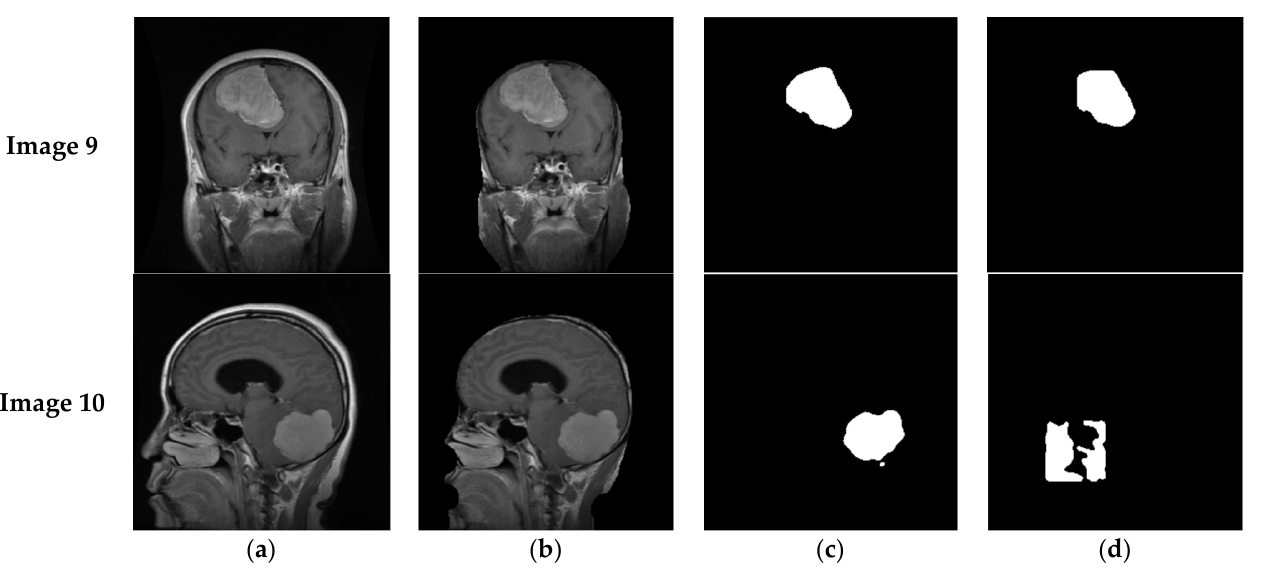
Figure 13. The efficiency of brain tumor segmentation on the KICA dataset: comparison of ANOVA and SAD-based methods. ( a ) Original images. ( b ) Pre-processing. ( c ) Our method with ANOVA. ( d ) Our method with SAD. Table 4. The results of our segmentation method on the KICA dataset, using the Dice similarity coefficient, Jaccard distance, correlation coefficient, and RMSE metric with two fitness functions: ANOVA and SAD.